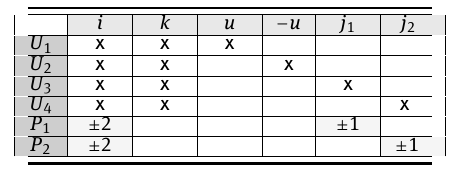
Table 8. Index distribution of U 1 , . . . , U 4 ∈ D ik ∪ E ik and index value distribution of P 1 , P 2 ∈ H i .